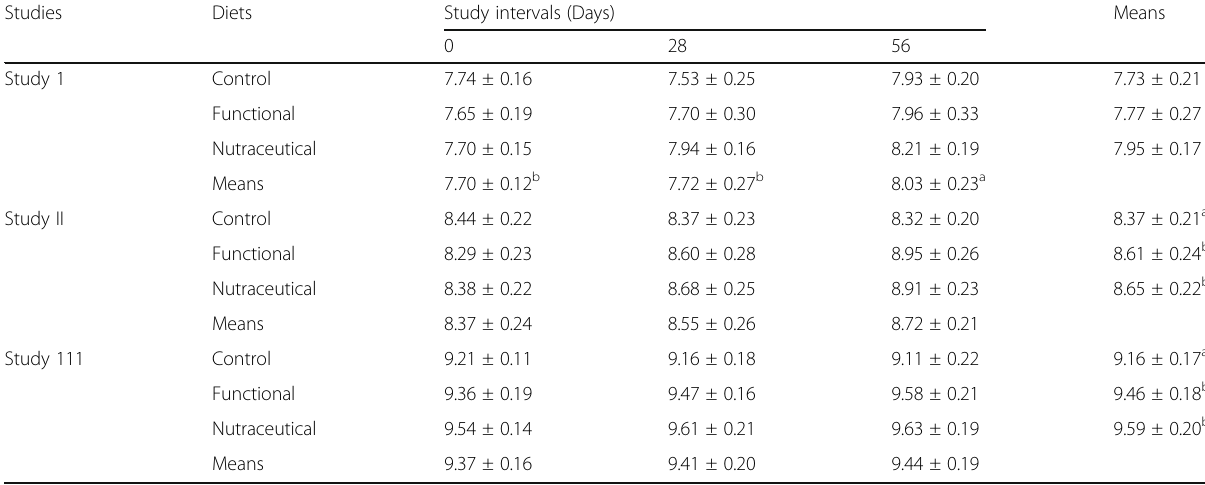
Table 8 Effect of diets and study intervals on RBC (10 6 / μ L) of rats in different studies Studies